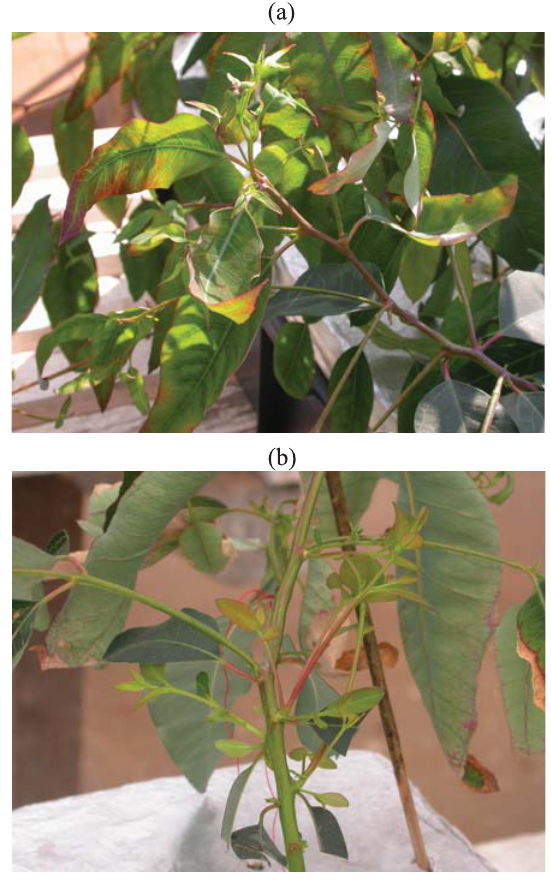
Figure 1. Boron deficient eucalypt plant (a) and emission of lateral sprouts 17 days after 10 B application to a single mature leaf of the B- deficient